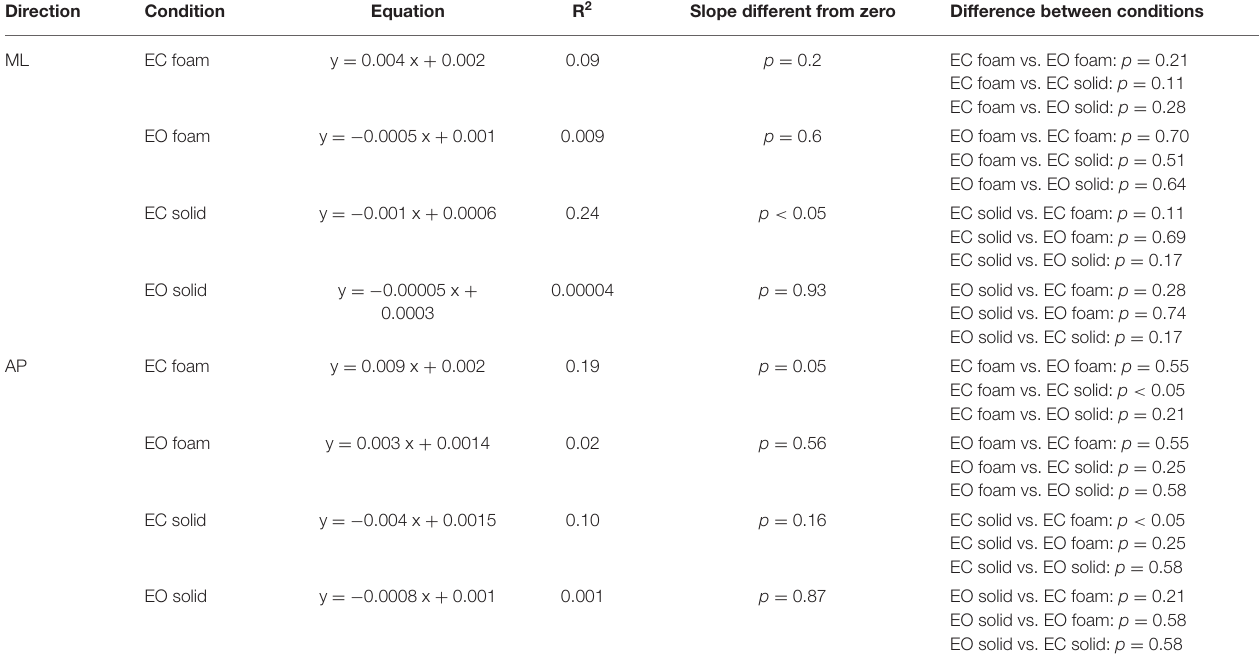
TABLE 5 | Relationship between mean Spectrum Level and Median Frequency. Direction Condition Equation Slope different from zero